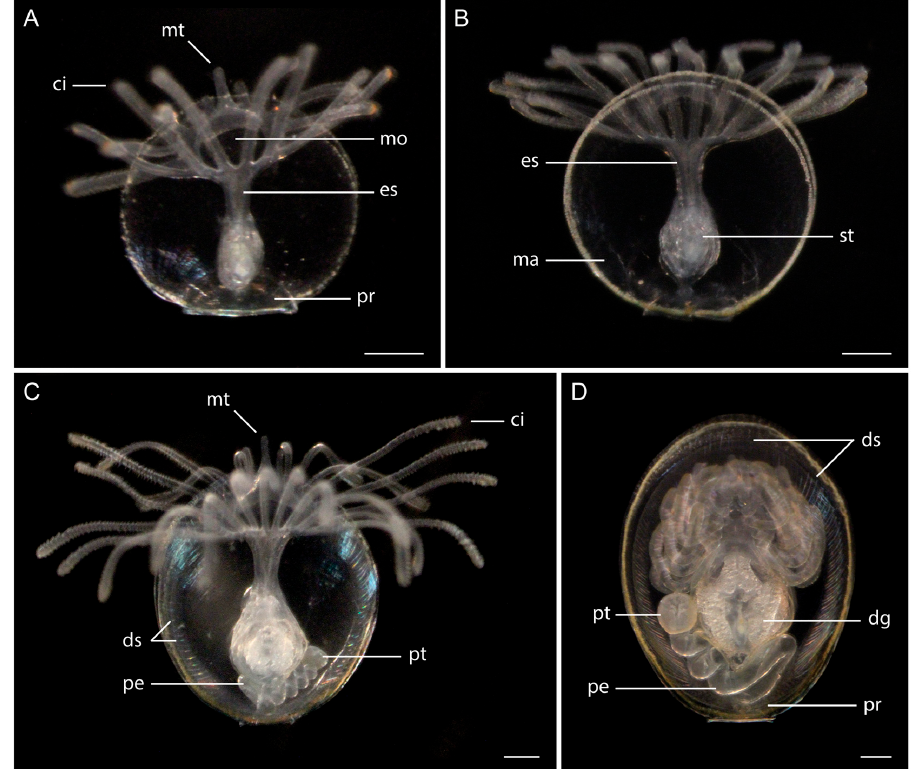
Figure 3. Larval Glottidia from the Bay of Panama. ( A ) Early stage larva with six pairs of cirri, a defined protegulum, and no pedicle; ( B ) Larva with ten pairs of cirri and initiation of the pedicle bud; ( C ) Larva with twelve pairs of cirri, elongate shell, definitive setae around the shell margin and a pedicle; ( D ) Late larva with definitive setae and a well ‐ developed pedicle. Abbreviations: dg, digestive glands; ds, definitive setae; es, esophagus; ma, mantle; mo, mouth; mt, median tentacle; pe, pedicle; pr, protegulum; pt, pedicle tip; te, tentacle. Scale bars = 100 μ m.